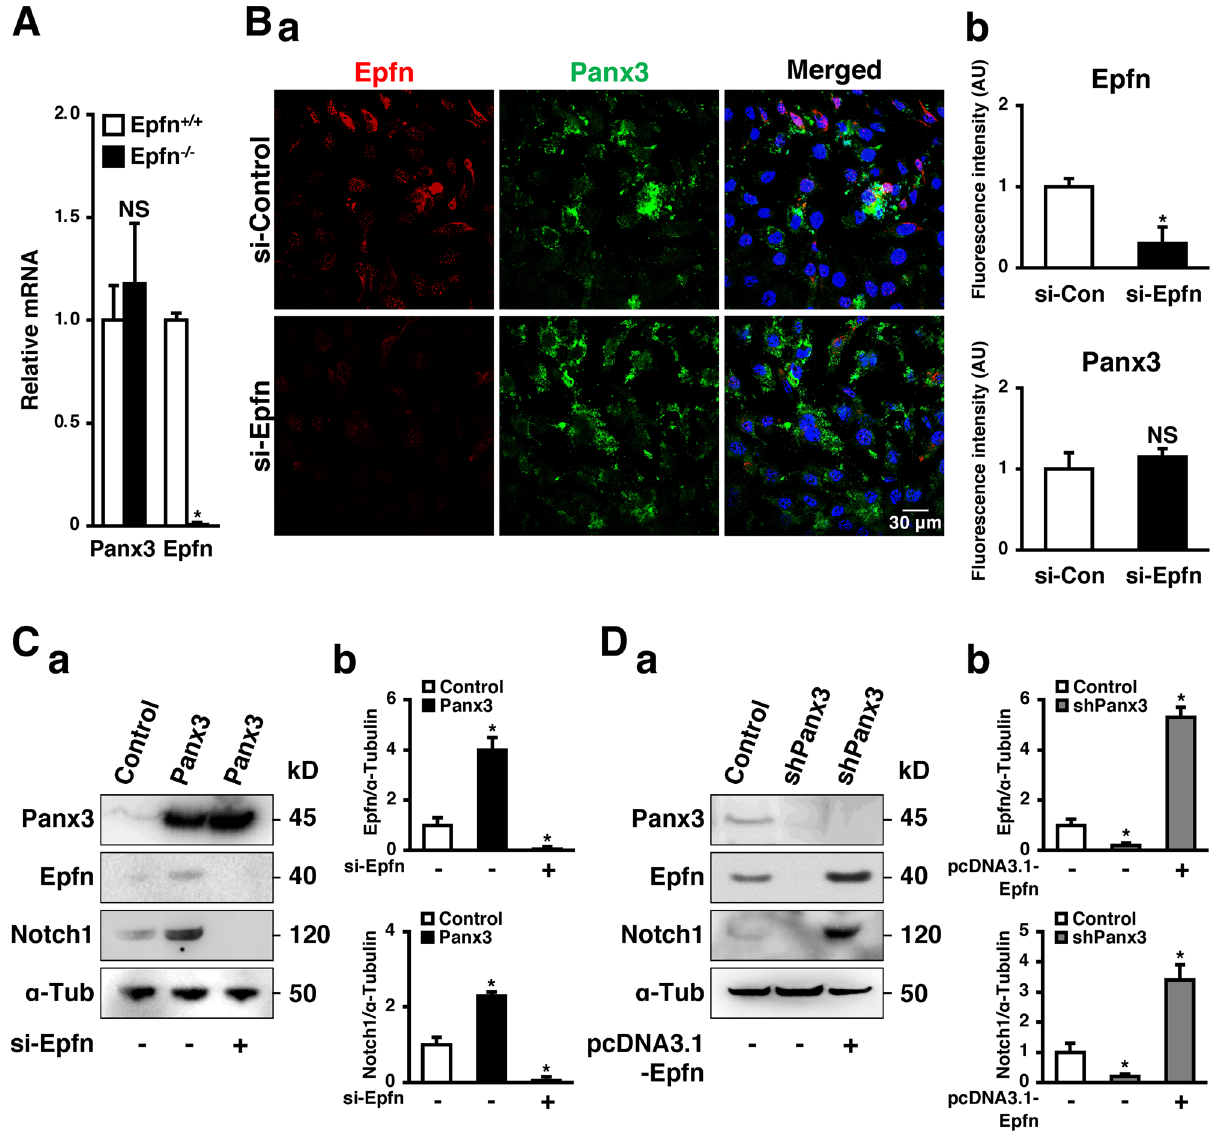
Figure 6. Epfn deficiency does not interfere with Panx3 expression. ( A ) qPCR for Panx3 and Epfn using total RNA prepared from skin of 6 weeks old Epfn +/+ and Epfn −/− mice. Results represent the mean ± SD; N = 3. * p < 0.01. NS, not significant. ( B ) Immunostaining of Panx3 (green) and Epfn (red) in si-Control or si-Epfn transfected HaCaT cells cultured in normal medium. The nuclei were counterstained with DAPI (blue in merged) ( a ). Relative fluorescence intensity comparison of images were analyzed ( b ). ( C ) Western blots of Epfn and Notch1 in Panx3 overexpressed HaCaT cells transfected with or without si-Epfn ( a ). Quantification of the ratios of Epfn/α-Tubulin (upper panel) and Notch1/α-Tubulin (lower panel). ( D ) Western blots of Epfn and Notch1 in shPanx3 transfected HaCaT cells with or without pcDNA3.1-Epfn ( a ). Quantification of the ratios of Epfn/α-Tubulin (upper panel) and Notch1/α-Tubulin (lower panel). * p < 0.01. NS, not Panx3 mediated ATP and Ca 2+ signaling could be involved. To answer this question, we analyzed the activation of Akt and NFAT in HaCaT cells by Western blotting (Fig. 7). Panx3 overexpression promoted phosphorylation of Akt and the level of dephosphorylated NFATc1 (active form) (Fig. 7A,B). We also found Epfn and Notch1 were also increased by Panx3 overexpression. To analyze how Panx3 channel functions are involved, we first applied Panx3 antibody to block Panx3 ATP at the cell membrane 11,14 . Application of Panx3 antibody inhibited both Akt and NFATc1 activation in Panx3 overexpressed cells and therefore decreased Epfn and Notch1 expres- sion. To test the 2nd function of Panx3 as an ER Ca 2+ channel mediated by ATP/PI3K/Akt signals 14,19 , a muta- tion was introduced to Panx3 at serine 68 (Ser68Ala) . to impair Panx3 ER Ca 2+ release 18 . Ser68Ala inhibited the activation of NFATc1 and both Epfn and Notch1 expression (Fig. 7A, a, b and c). These results suggest that Panx3 as an ER Ca 2+ channel strongly regulates Epfn expression through NFATc1/Ca 2+ signaling for keratinocyte differentiation. Further, since Panx3 ER Ca 2+ channel is activated by Akt signaling 14,18,19 , we investigated Epfn